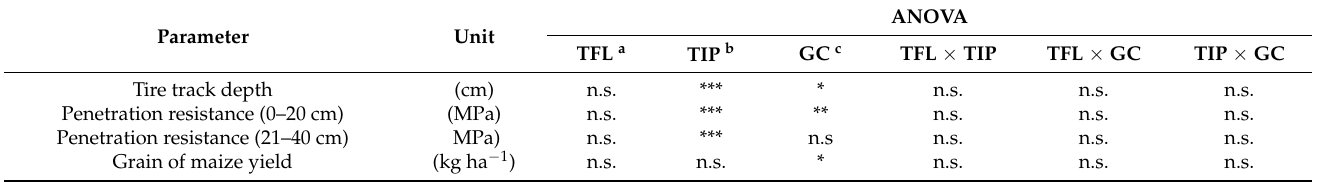
Table 2. ANOVA results of tire track depth, soil penetration resistance (averaged for each depth), and grain of maize yield. ANOVA Parameter Unit TFL a TIP b GC c TFL × TIP TFL × GC TIP × GC Tire track depth (cm)